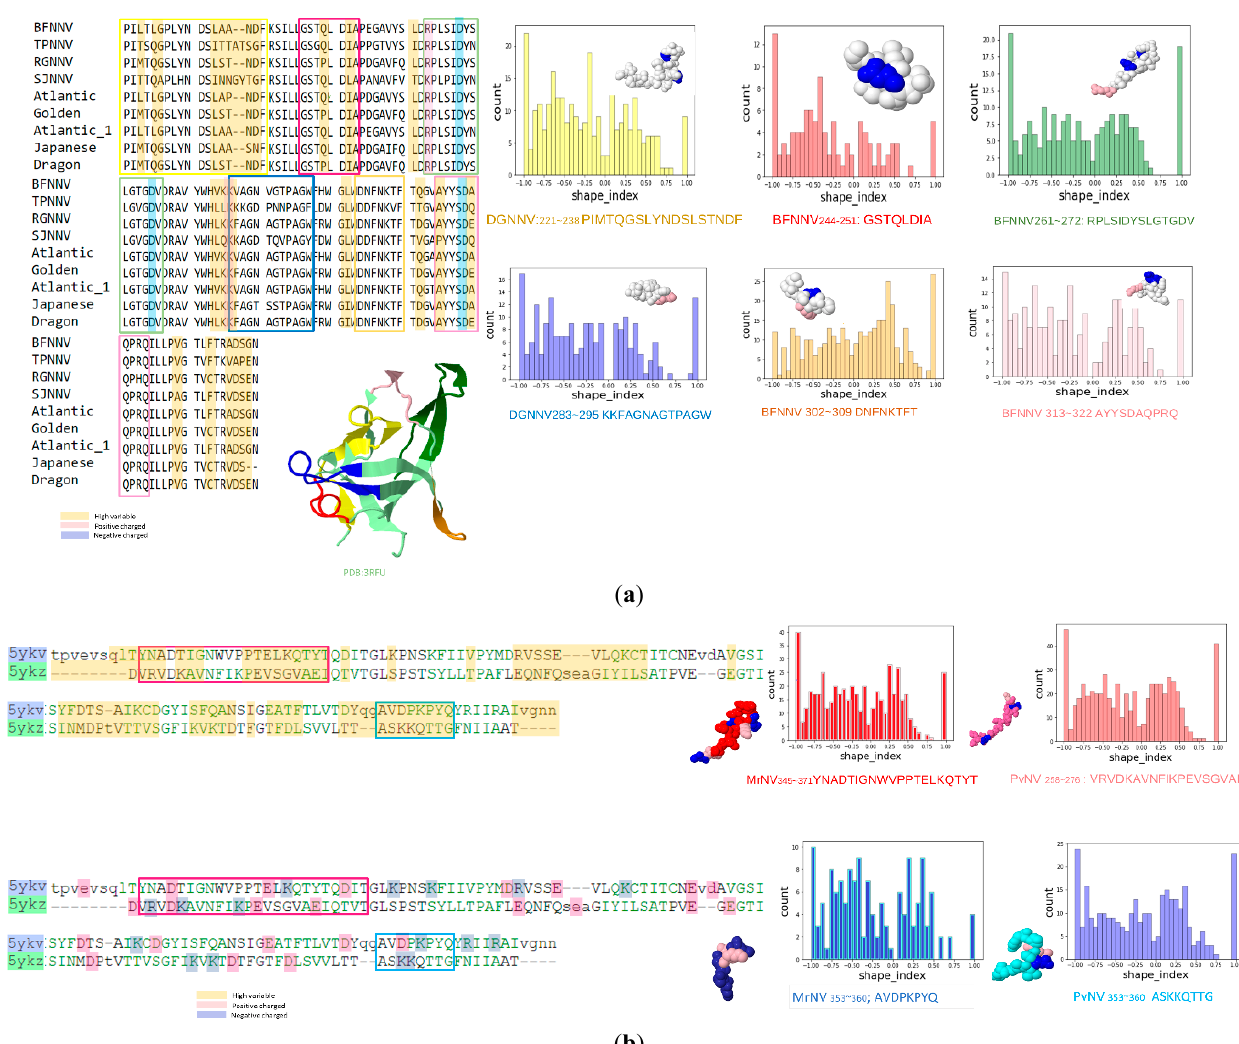
Figure 7. Shape index of predicted epitope from betanodavirus and gammanodavirus. The surfaces of the predicted epitopes were extracted from betanodavirus (4RFT) and gammanodavirus (5YKV and 5YKZ) with MSMS. PyMesh is then applied to calculate the Gaussian and mean curvatures for each vertex and to further calculate the shape index (SI). Each histogram is represented using the corresponding color of the peptide from the sequence alignment. ( a ) Epitopes of betanodaviruses; ( b ) epitopes of